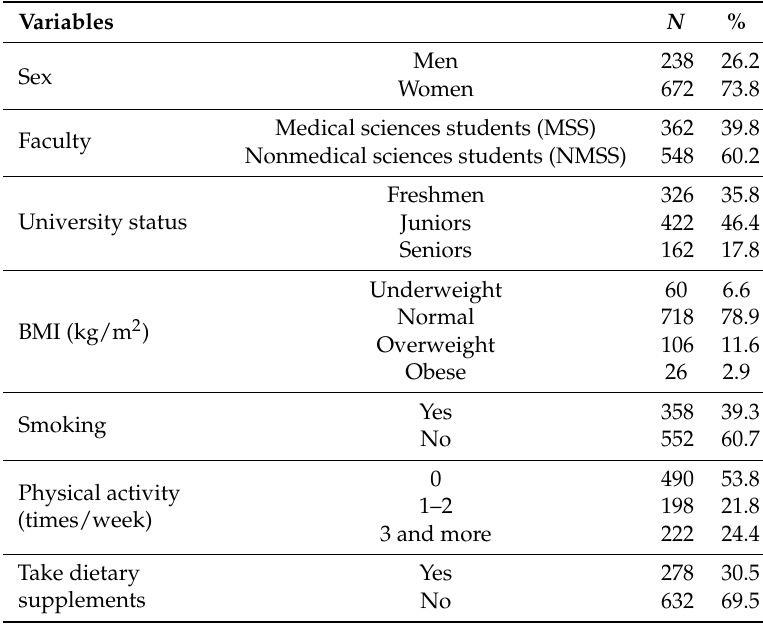
Table 1. Sociodemographic and lifestyle characteristics of study participants ( N =